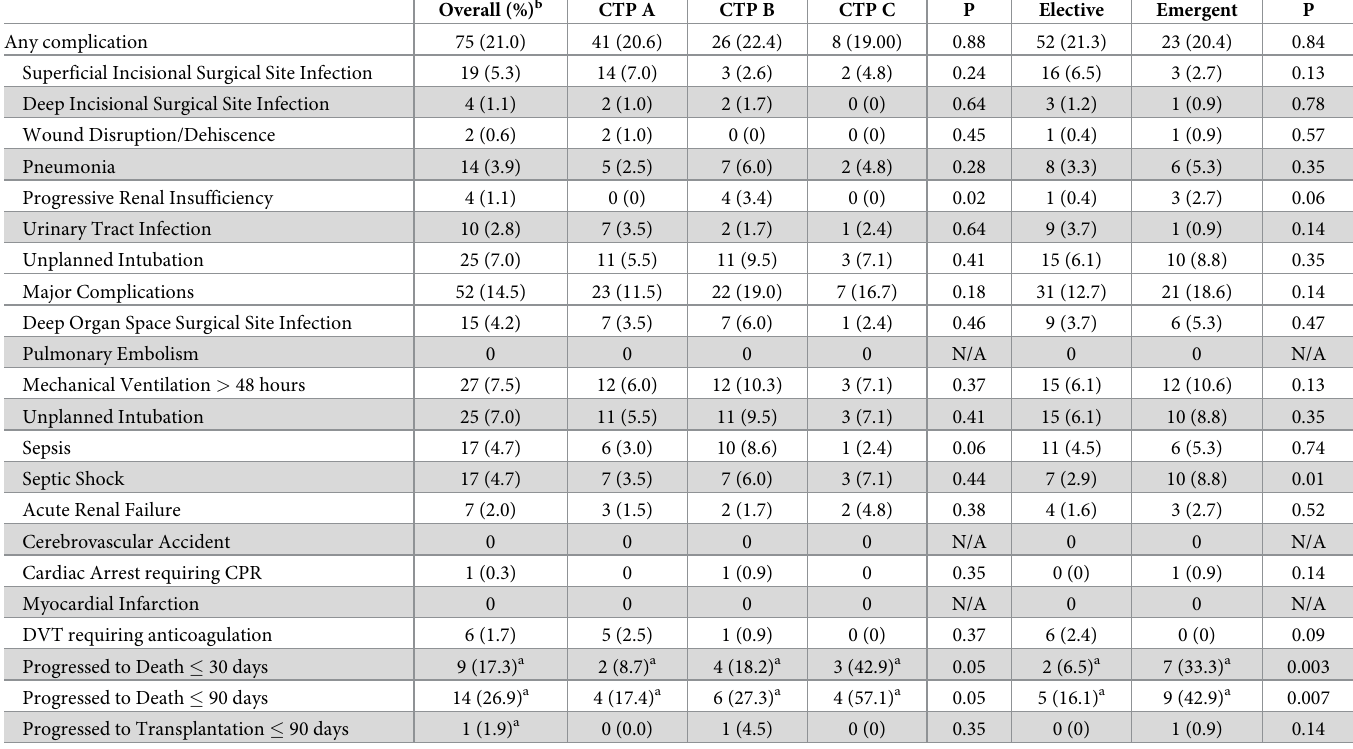
Table 6. Post-operative complications and rescue